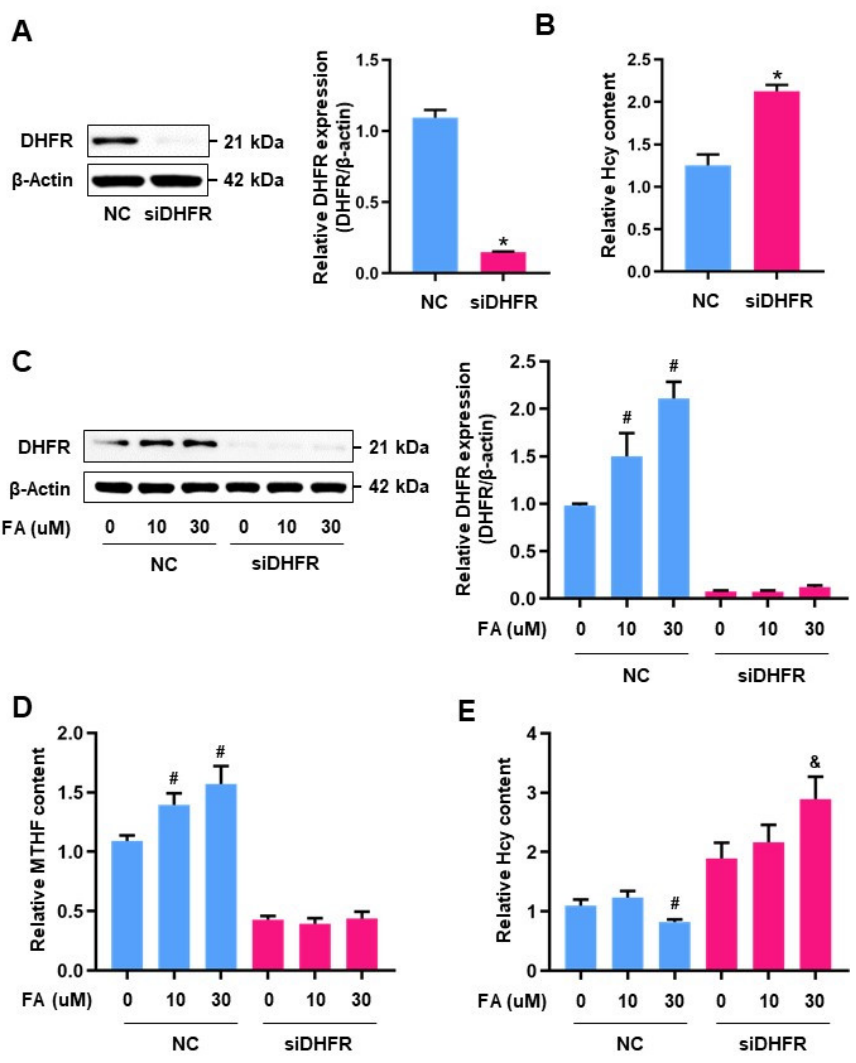
Figure 3. The effect of DHFR deficiency on homocysteine and folate intermediates in HUVECs: ( A ) Western blot analysis for DHFR expression in HUVECs after silencing DHFR by using 100 pmol siRNA over 48 h. The expression level of DHFR was quantified densitometrically. ( B ) The Hcy content of supernatant media of siDHFR-treated HUVECs was measured. Data are presented with three independent experiments as the mean ± SEM. * p < 0.05 compared with NC-treated cells. ( C ) HUVECs transfected with 100 pmol siDHFR before 10 µ M or 30 µ M FA treatment were used for measuring the protein level of DHFR. Densitometric analysis of DHFR expression is shown as a graph relatively. ( D ) Fluorescent-HPLC analysis of MTHF content using the. peak height of siDHFR-transfected HUVECs before FA treatments. ( E ) Relative quantification of the Hcy level with NC or DHFR siRNA with/without FA. Data are presented with three independent experiments as the mean ± SEM. # p < 0.05 versus NC-treated cells with 0 µ M FA in the NC group, & p < 0.05 versus siDHFR-treated cells with 0 µ M FA in the siDHFR group.